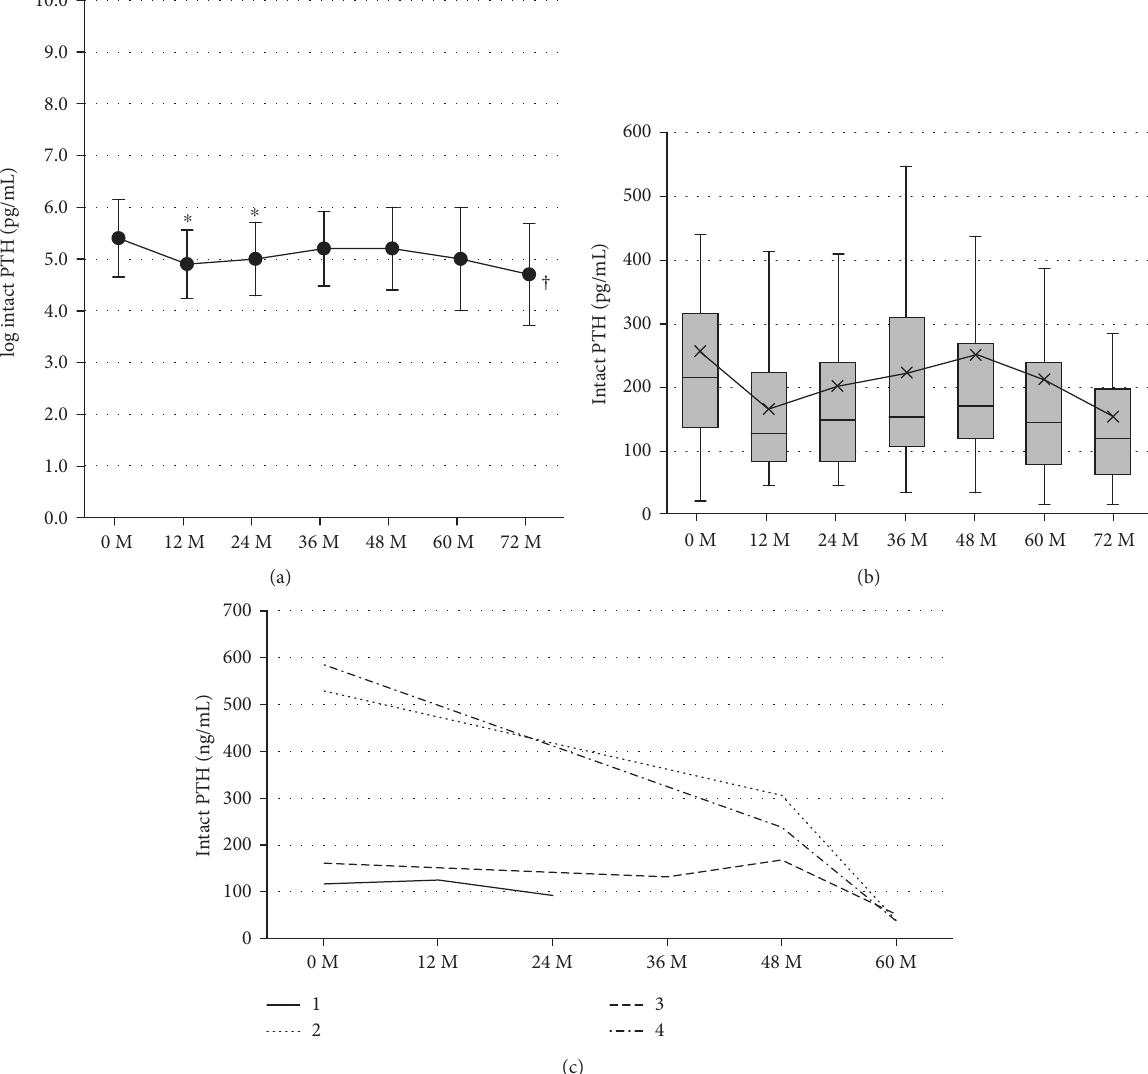
Figure 1: Levels of log intact PTH (mean ± SD) (a) and intact PTH (median, IQR) (b) at baseline and at 12, 24, 36, 48, 60, and 72 months following renal transplantation without parathyroidectomy and levels of intact PTH (c) at baseline and at 12, 24, 36, 48, and 60 months following renal transplantation in patients who received parathyroidectomy posttransplantation. PTH, parathyroid hormone. ∗ P value < 0.05 vs. 0 M Tukey’s test. † P value < 0.05, multivariate repeated-measures